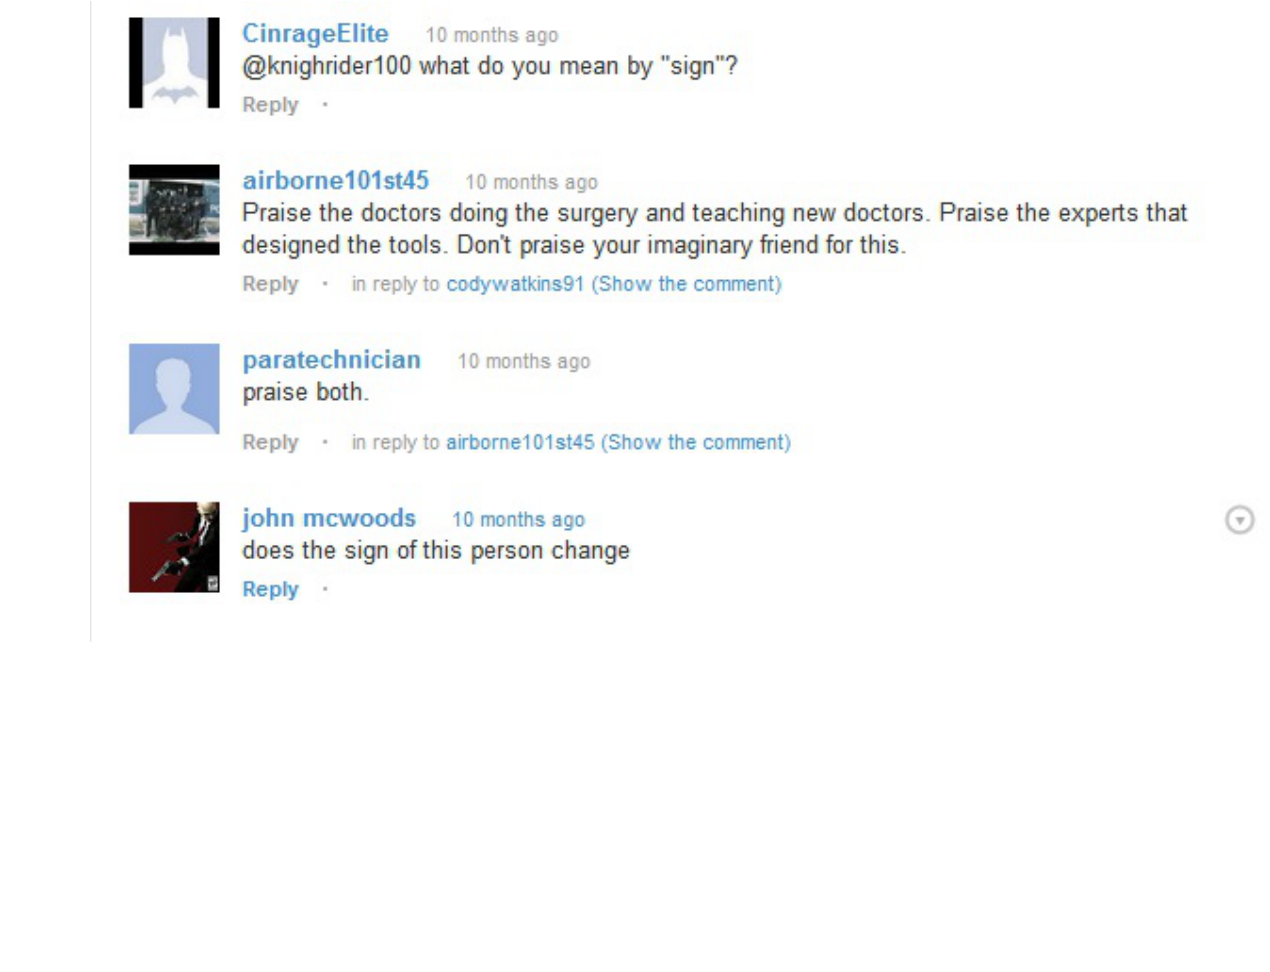
Figure 3. A screenshot of the commendable from Web viewers (on April 12,